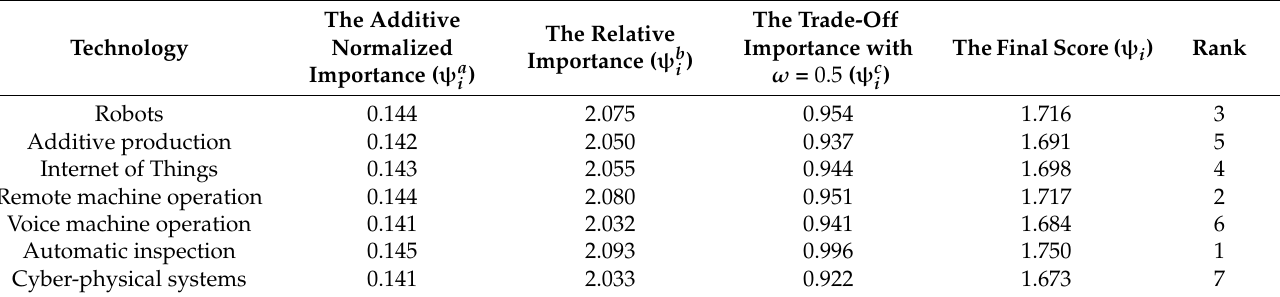
Table 4. The R-SF CoCoSo results with ω = 0.5.